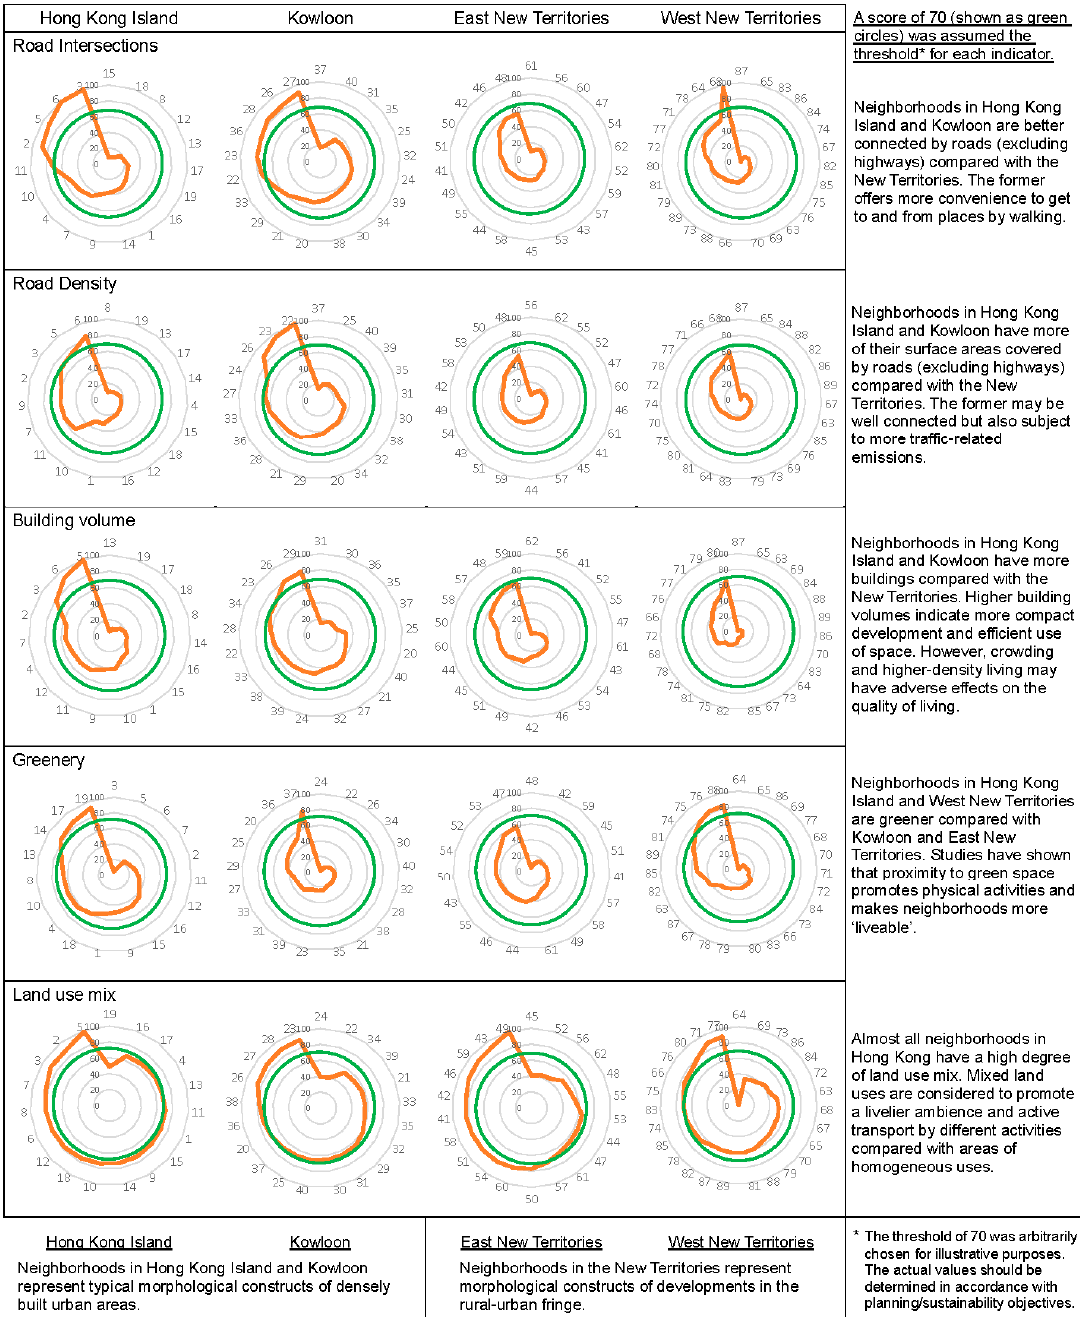
Figure 2. Radar charts of morphological metrics (based on normalized scores) by geographic regions of Hong Kong.